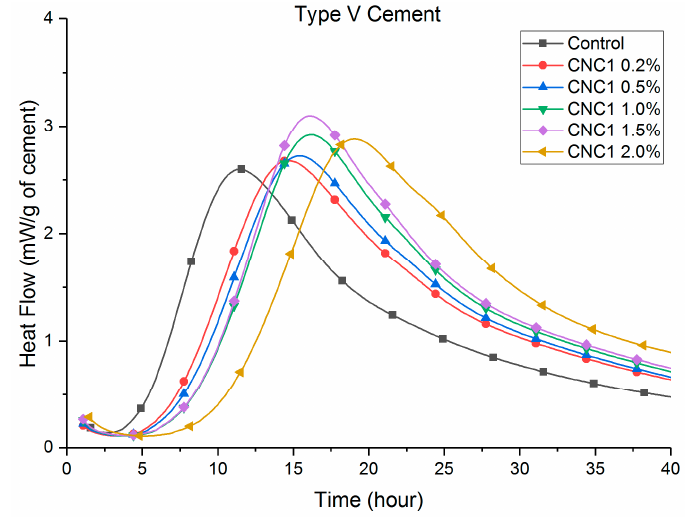
Figure 5. Heat flow of Type V cement, CNC1 at different dosages.